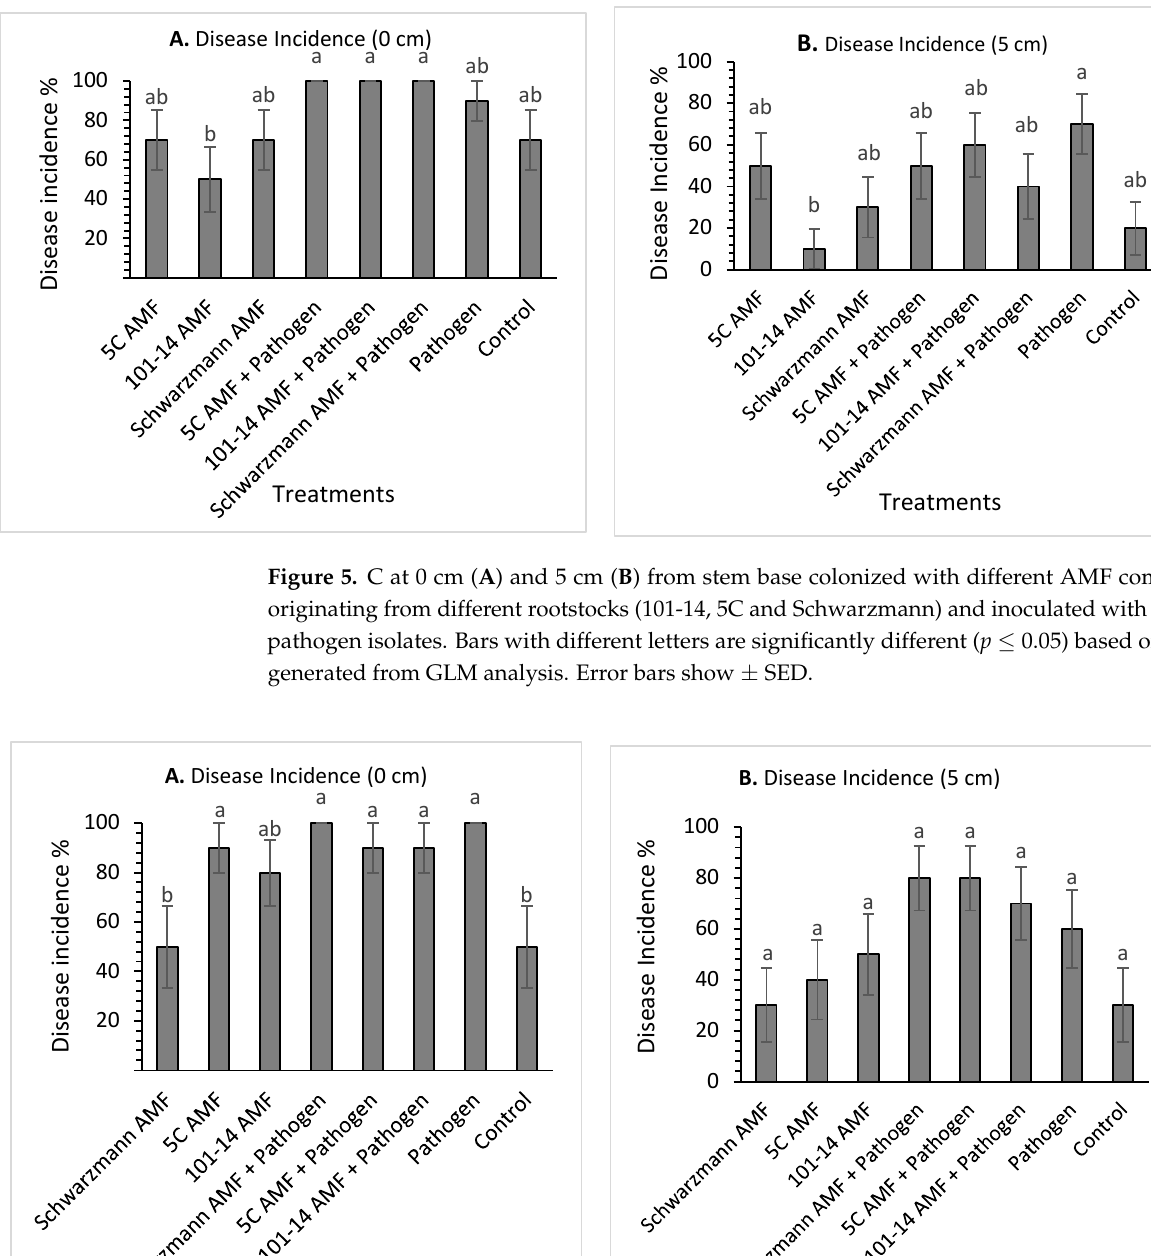
Figure 5. C at 0 cm ( A ) and 5 cm ( B ) from stem base colonized with different AMF communities originating from different rootstocks (101-14, 5C and Schwarzmann) and inoculated with black foot pathogen isolates. Bars with different letters are significantly different ( p ≤ 0.05) based on the SED generated from GLM analysis. Error bars show ± SED.